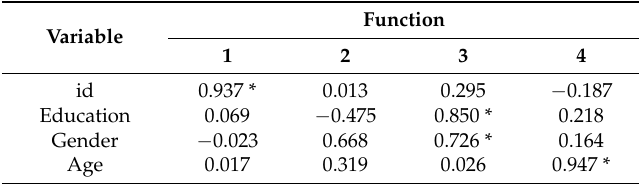
Table 3. Structure matrix for functions 1 through